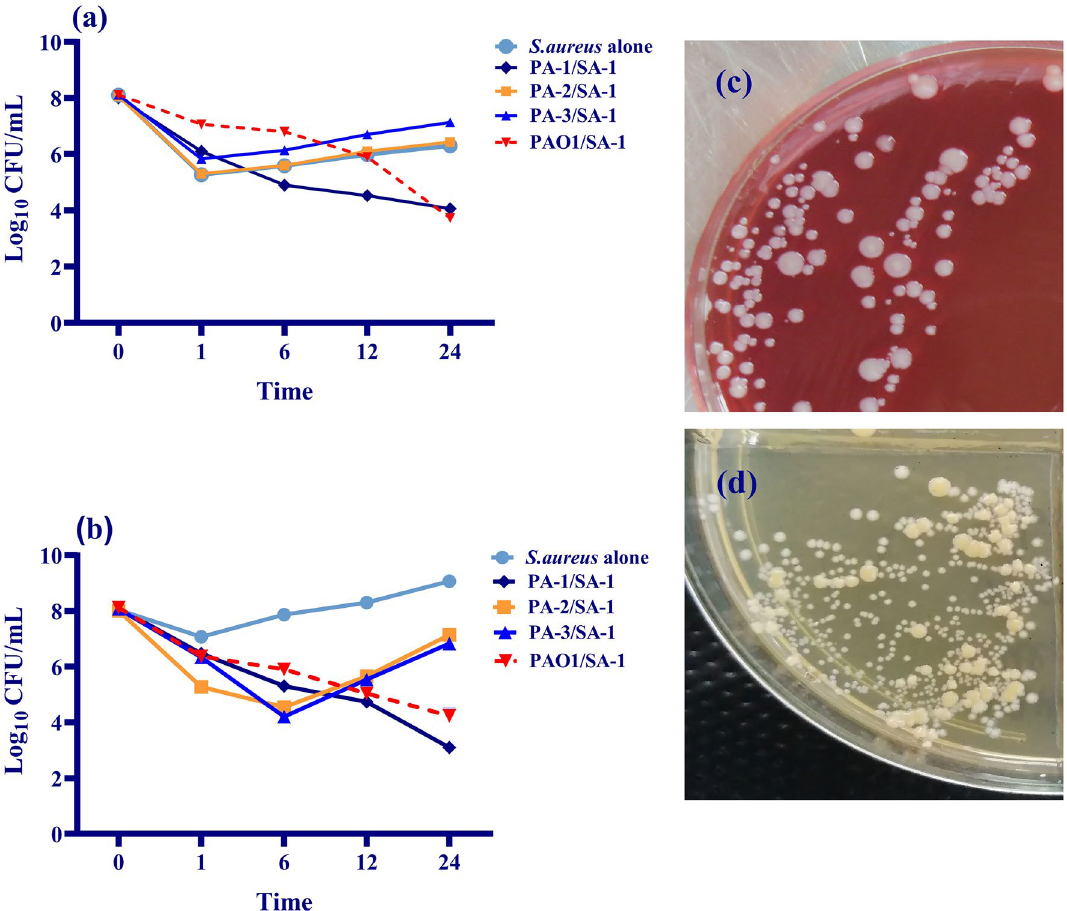
Figure 1. Co-culture evaluation of S. aureus and four strains of P. aeruginosa on the L929 cell line. The recovered strains from co-culture were determined as log 10 CFU/mL counts. ( a ) The slow-growing colonies of S. aureus recovered from co-culture with different strains of P. aeruginosa in the planktonic state. ( b ) The slow- growing colonies of S. aureus recovered from co-culture with different strains of P. aeruginosa in the